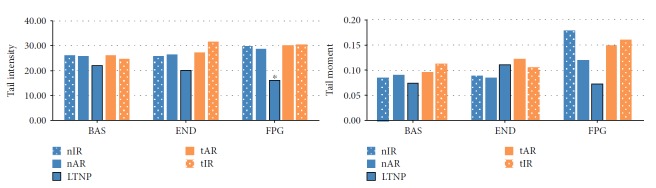
Leukocyte DNA damage of the 92 people living with HIV/AIDS, according to the five study groups, in three conditions—basal (BAS), that is, blades without enzymes treatment, or blades with enzymatic treatment (endonuclease III enzyme [END] and formanodipirimidina-DNA glycosylase, [FPG]). The LTNP group presented the lowest DNA damage; Statistical tests: gamma distribution for BAS-tm, END-tm and FPG-tm, and ANOVA for the others. ∗
p < 0.05, difference among all the other groups.